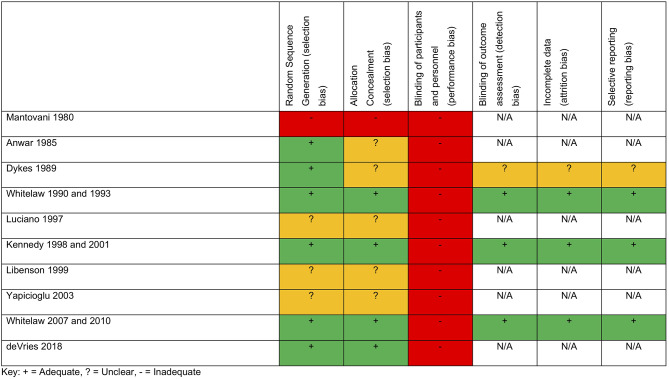
Quality measures.